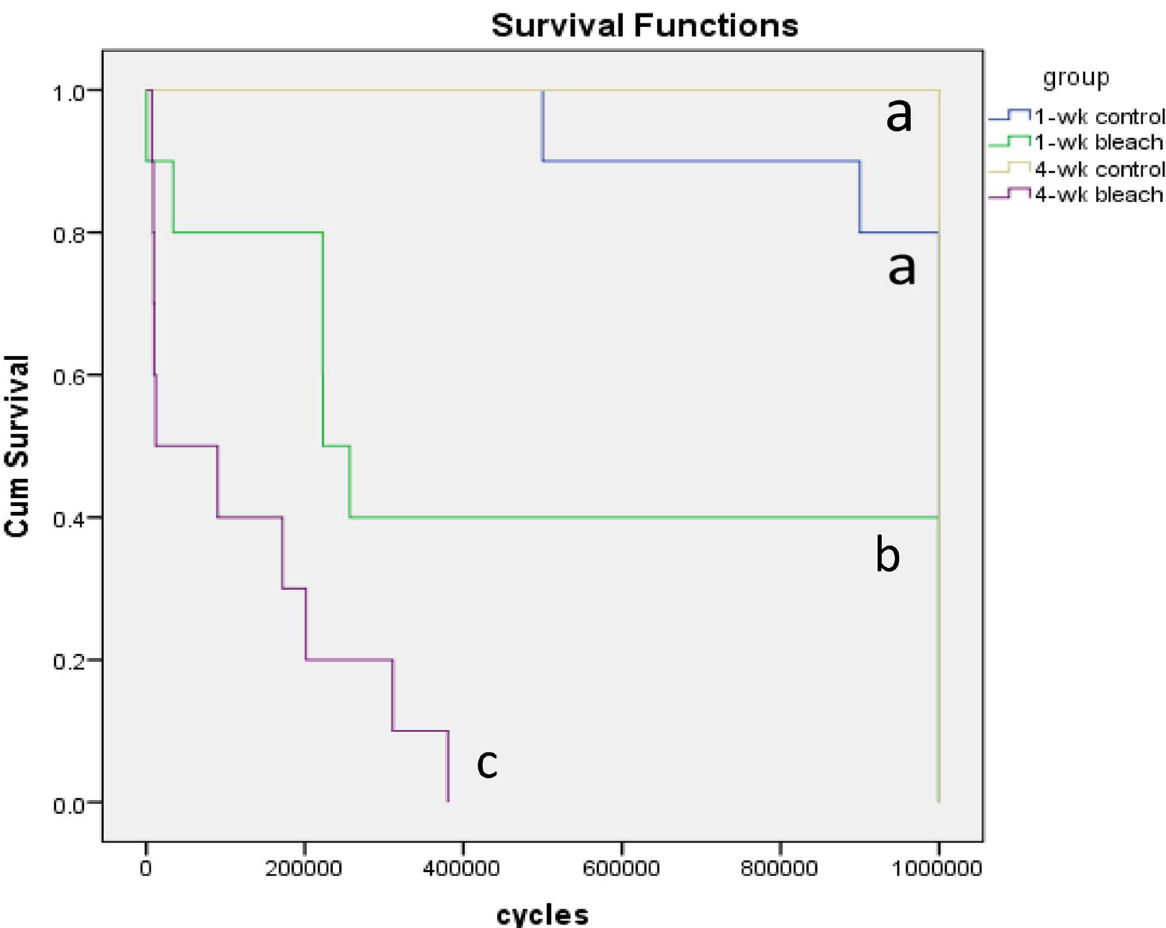
Fig 1. Survival plot. The cumulativesurvival of the specimens over the numberof cycles duringthe fatigue test is shown. The survival distributionsfor the interventions was significantly different (p < 0.001). Groups denotedby the same letter indicatesno significant difference (p <